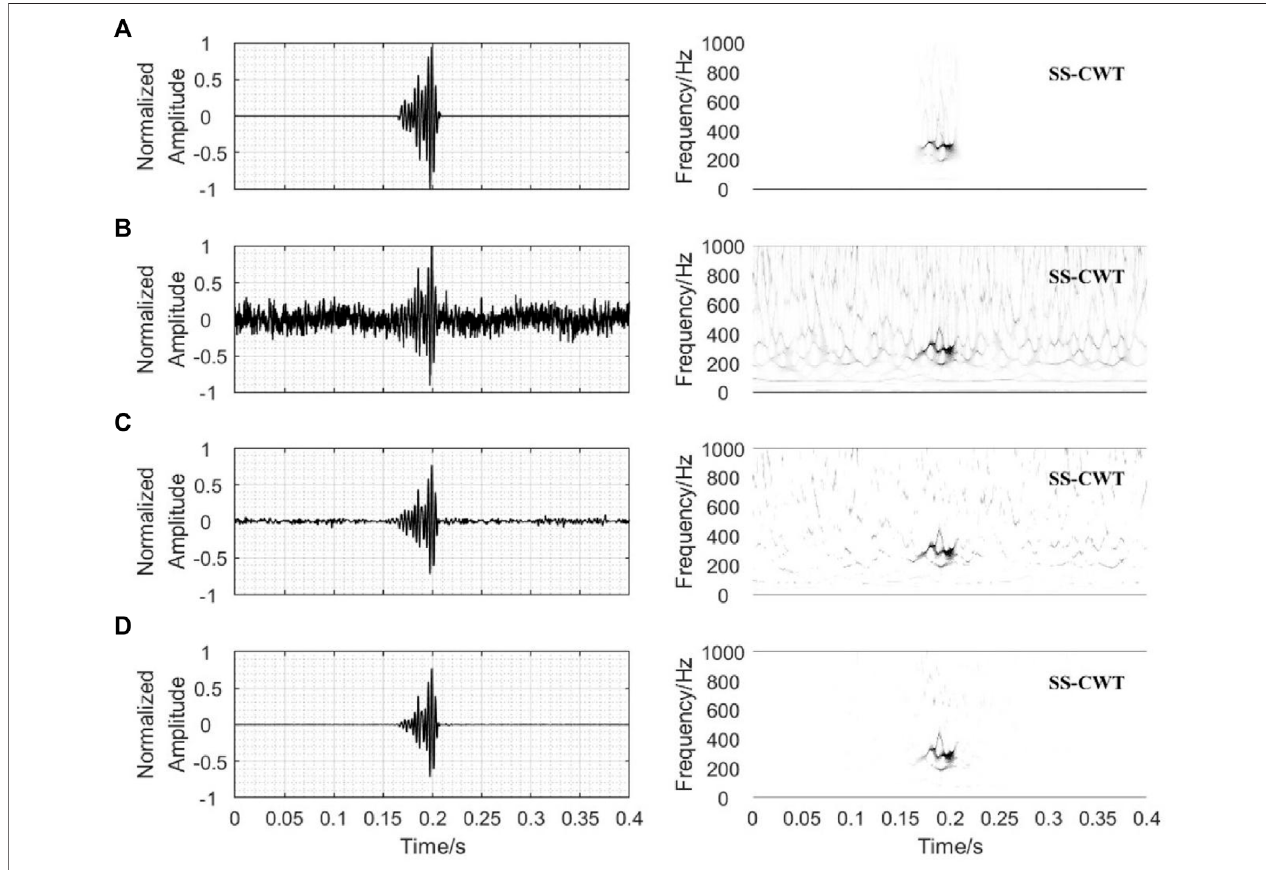
FIGURE3| Resultsofeachstepondenoising. (A) Syntheticoriginalsignal ’ swaveformandSS-CWTspectrogram. (B) SyntheticnoisysignalwaveformandSSWT spectrogram. (C) Denoising waveform and SS-CWT spectrogram after CDF thresholding. (D) Denoising waveform and SS-CWT spectrogram after post-processing.